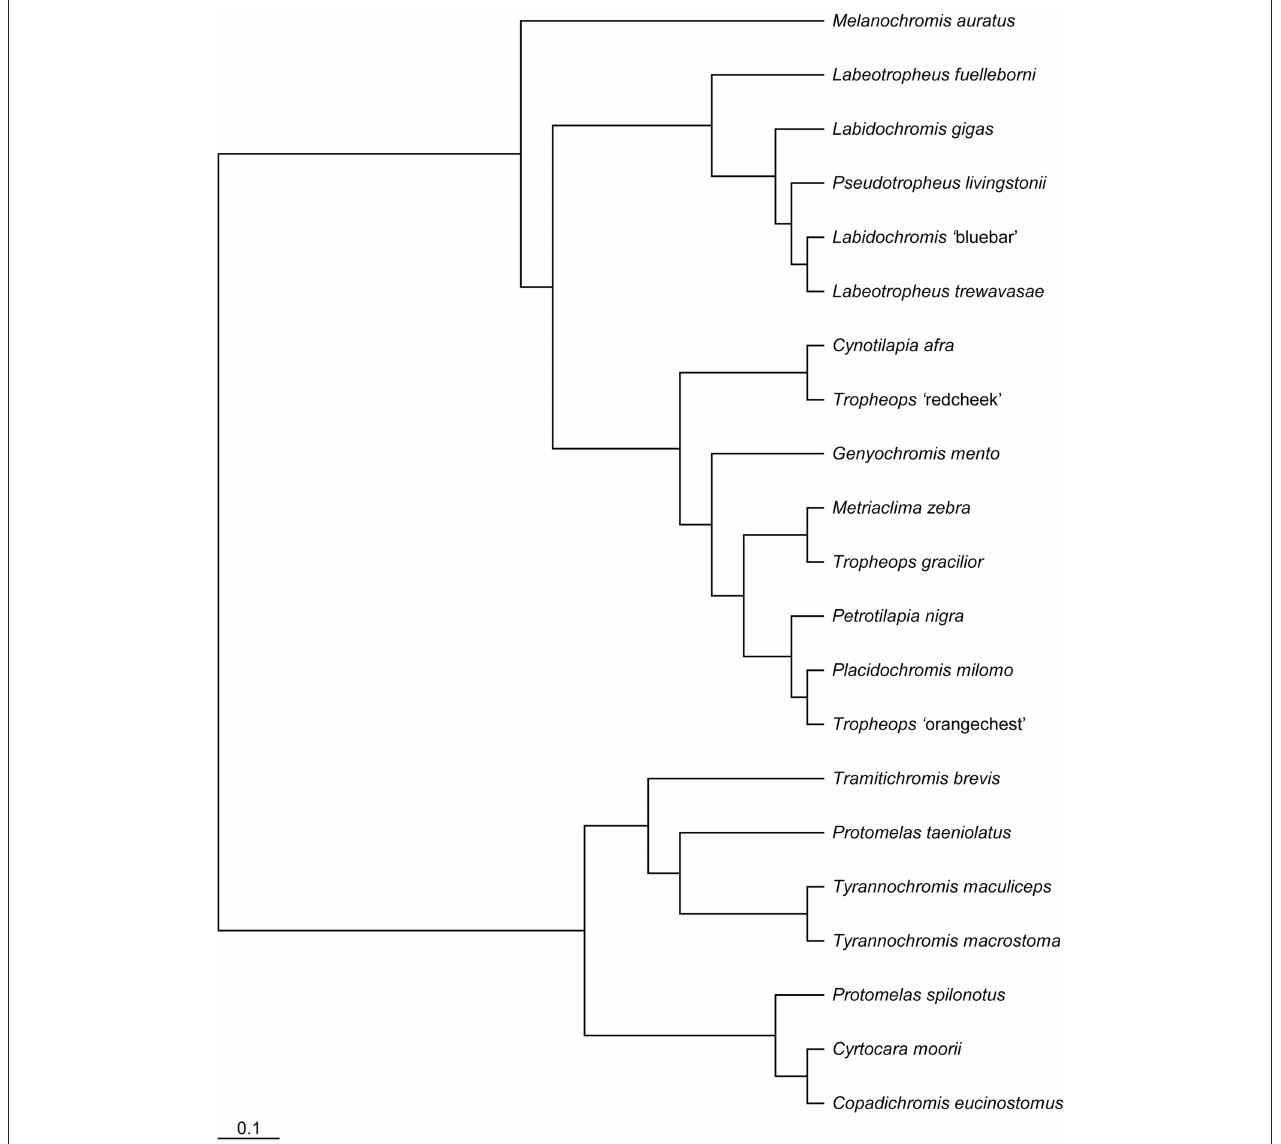
FIGURE 3 | One example of the 1000 trees generated from the phylogeny in Figure 1, containing the 21 species for which all ecological data were available.